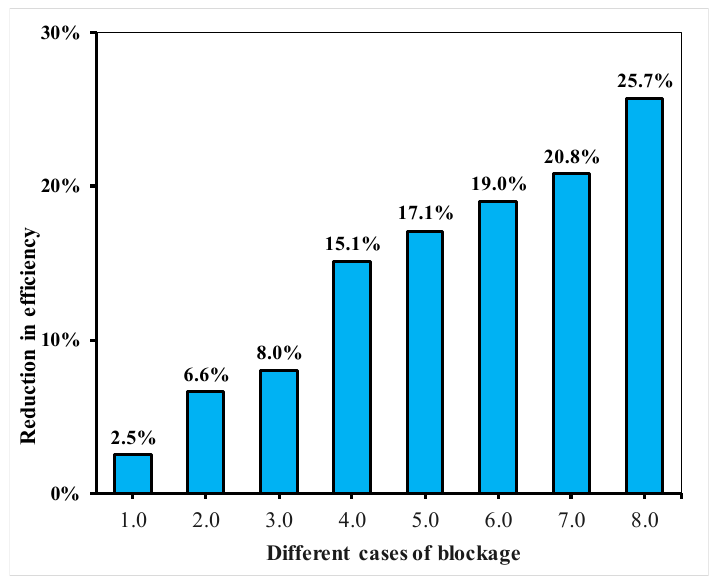
Figure 30. Reduction in efficiency tor different ratios.